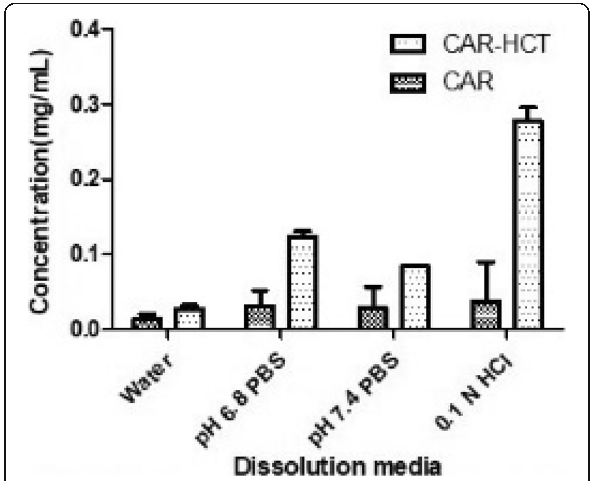
Fig. 10 Bar diagram showing the solubility of CAR and CAR-HCT cocrystal in different dissolution media ( n =